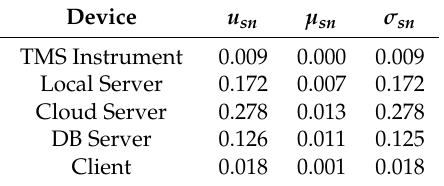
Table 1. Synchronization uncertainty of the devices involved in the experiments (ms).